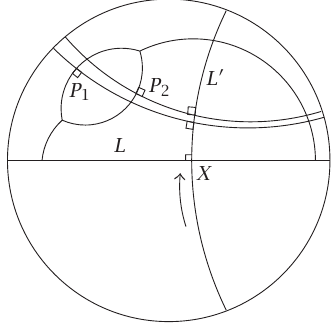
Figure 7.6 . Generating curve for a possible nonstandard minimizer, and a set of points p i from which orthogonal lines intersect the same geodesic orthogonal to the axis of revolution